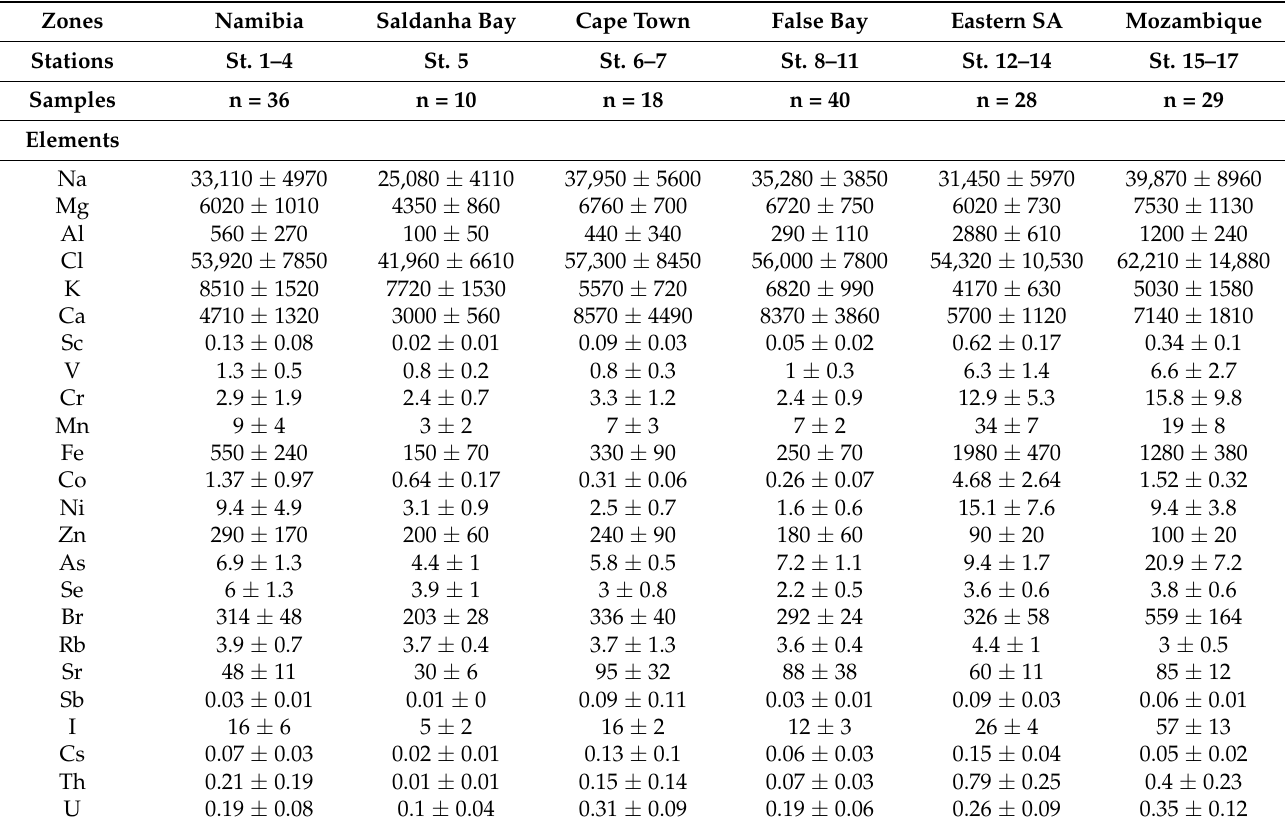
Table 2. Concentrations of elements (mean ± standard deviation, ppm, dry weight basis) in soft tissues of mussels among studied